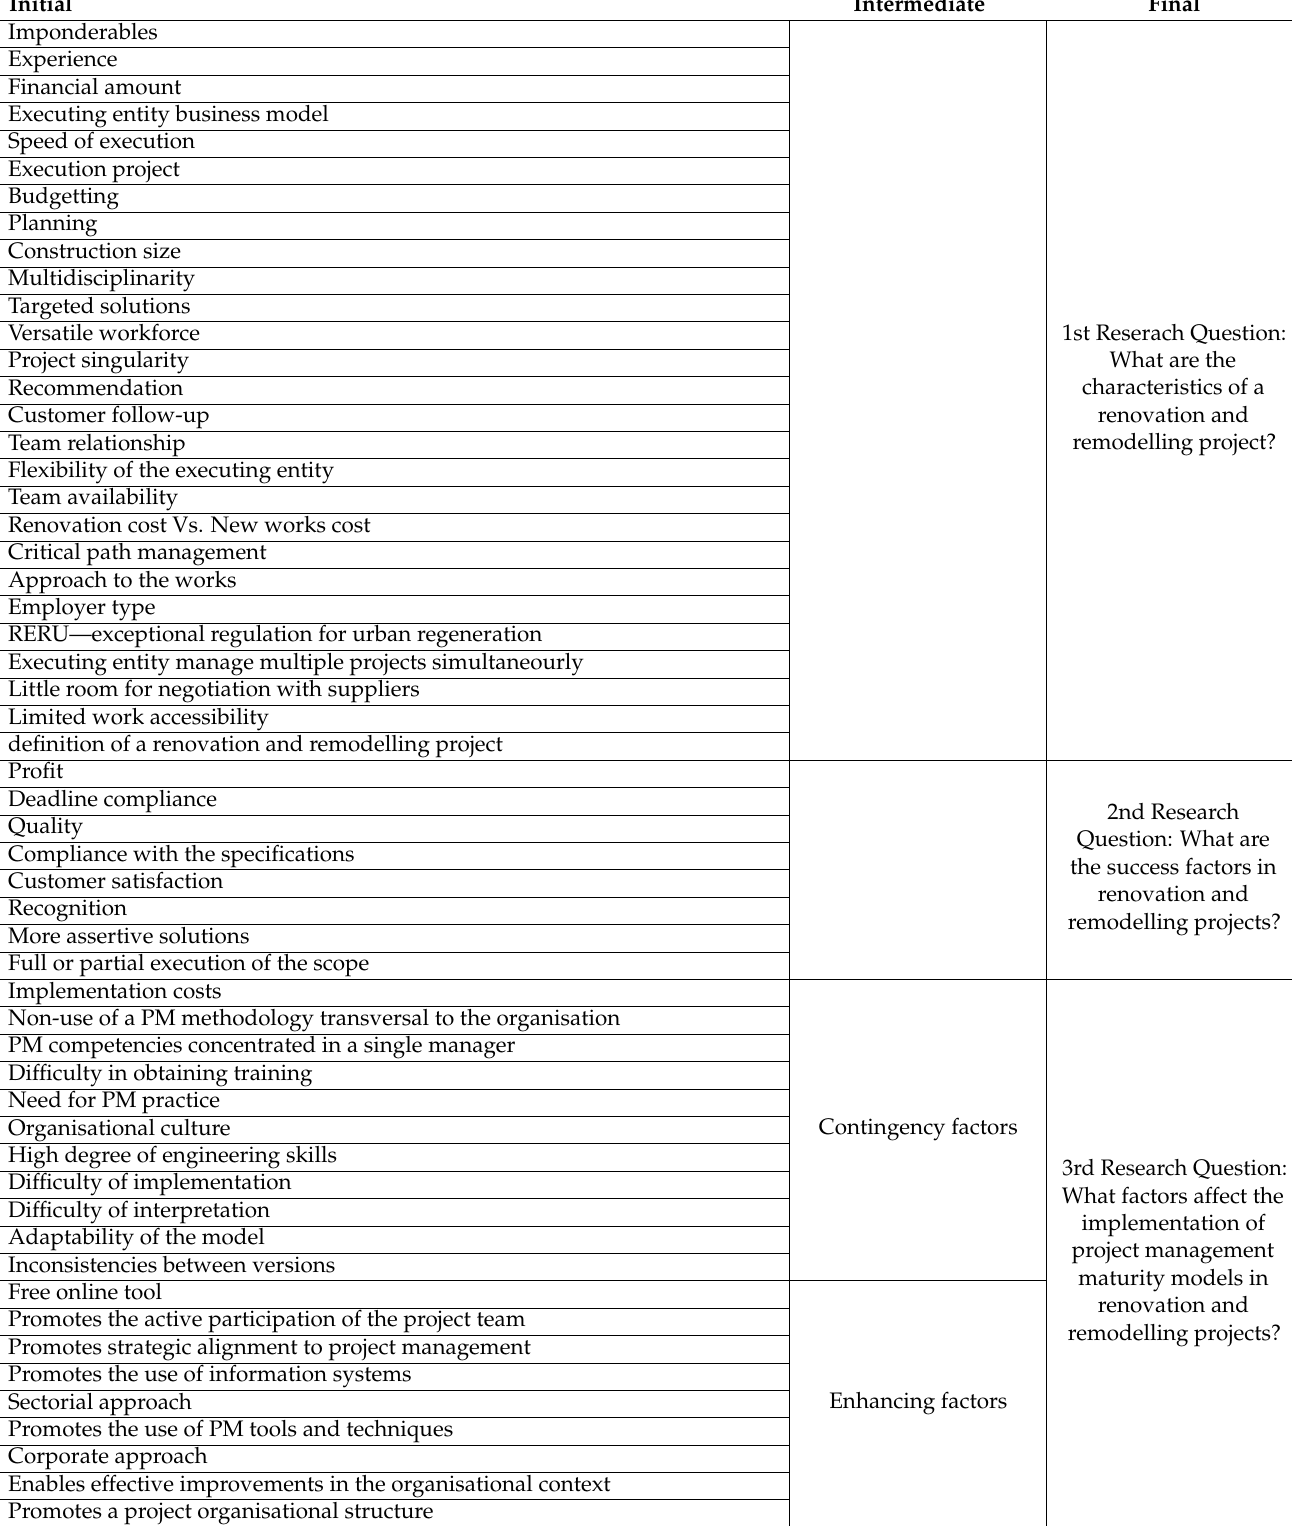
Table A6. Overview on the progression of